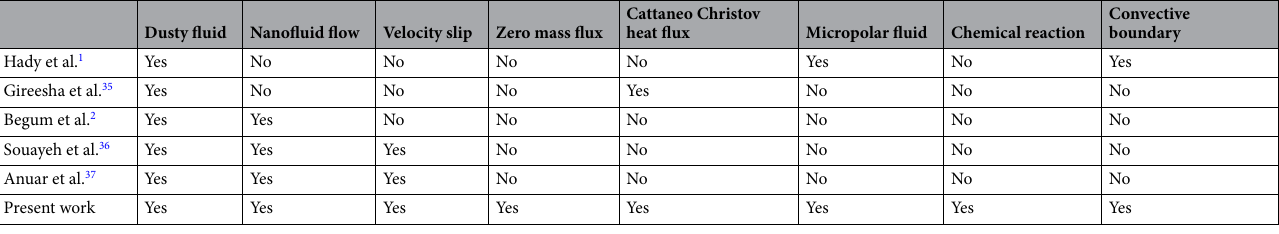
Table 1. Assessment of the present work with the close related published